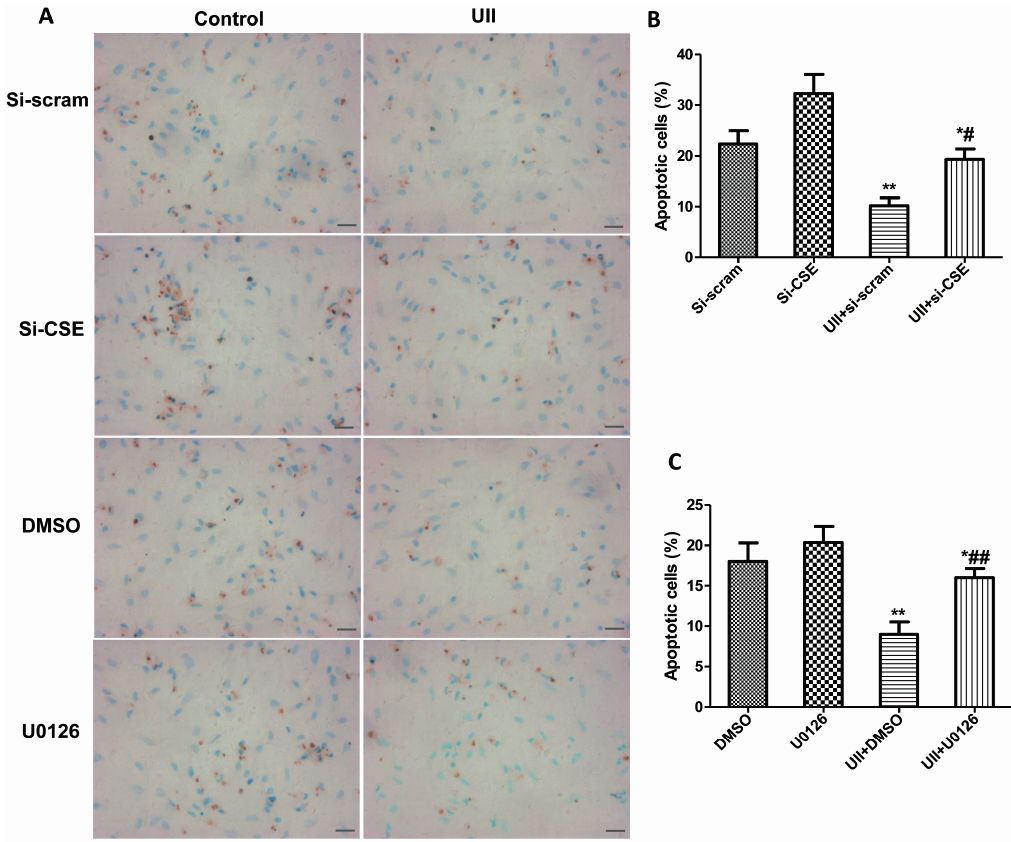
Figure 6. Si-CSE or ERK inhibitor partly abolishes the anti-apoptotic effects of UII on H 2 O 2 -treated-cardiomyocytes. ( A ) Representative images of TUNEL staining in cultured cardiomyocytes. Bar = 25 μ m; ( B ) Quantitative analysis of TUNEL staining in cultured cardiomyocytes transfected with si-scramble or si-CSE for 48 h, treated with UII (0.1 μ M) or PBS for 30 min, then exposed to 100 μ M H 2 O 2 for 24 h. Values are mean ± SEM. * p < 0.05, ** p < 0.01, UII + si-scram vs. Si-scramb or UII + si-CSE vs. Si-CSE. # p < 0.05. UII + si-CSE vs. UII + si-scram; ( C ) Quantitative analysis of TUNEL staining in cultured cardiomyocytes treated with DMSO or U0126 with or without UII for 30 min and exposed to 100 μ M H 2 O 2 for 24 h. Values are mean ± SEM. * p < 0.05, ** p < 0.01, UII vs. DMSO or UII + U0126 vs. UII + DMSO. ## p < 0.01 UII + U0126 vs. UII + DMSO. All experiments were repeated independently at least three